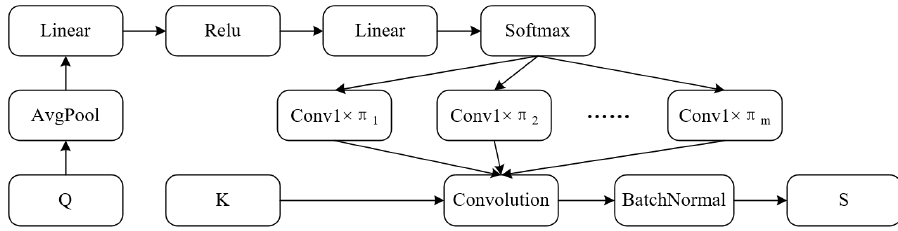
Figure 4. Flowchart of DY-CNNs attention. Figure 4. Flowchar t of DY-CNNs attention.